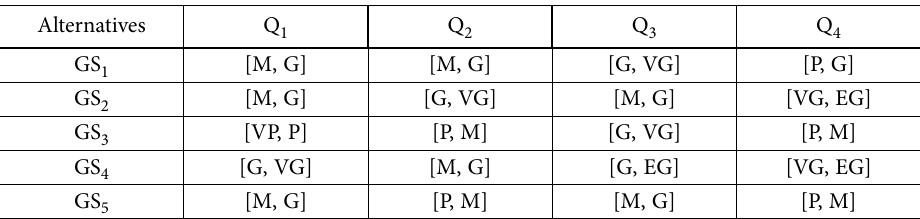
Table 1. The ULTSs through DM 1